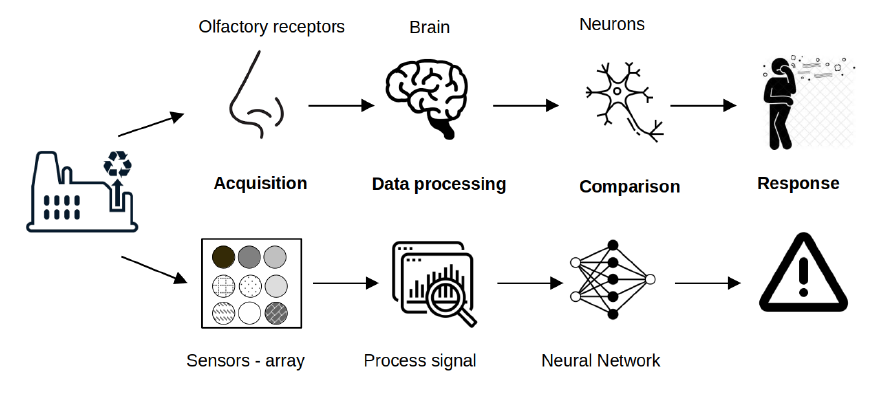
Figure 2. Structures of biological olfactory system and electronic